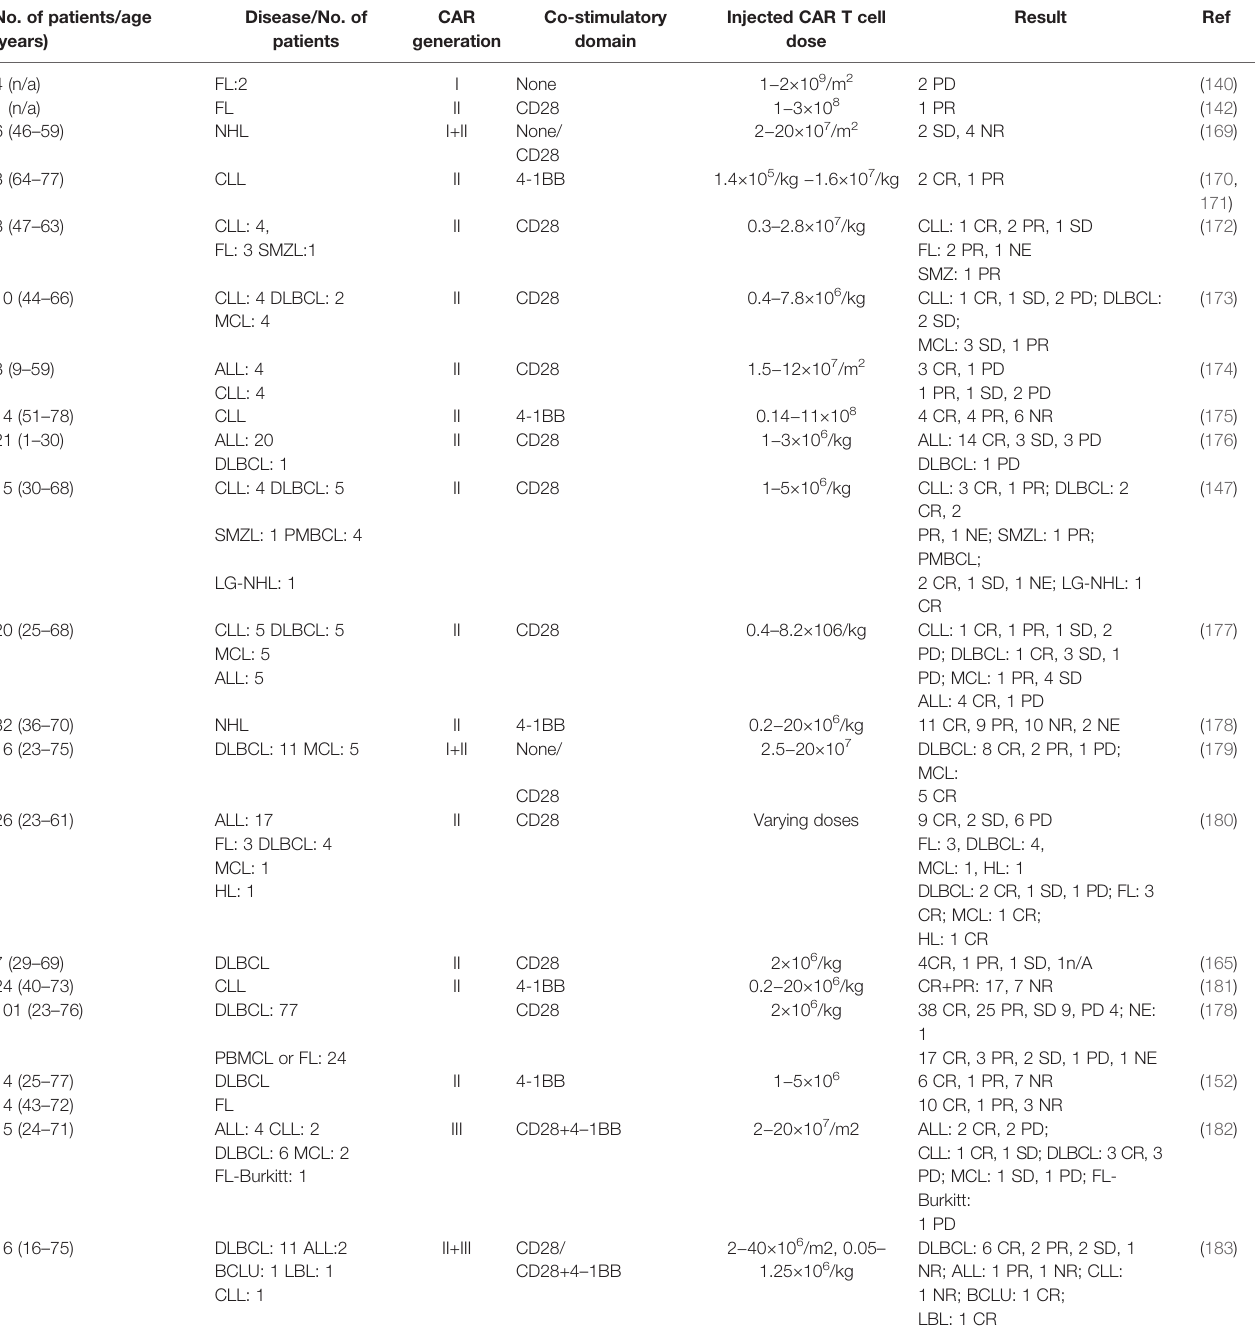
TABLE 2 | The clinical trials of CD19-targeted CAR T